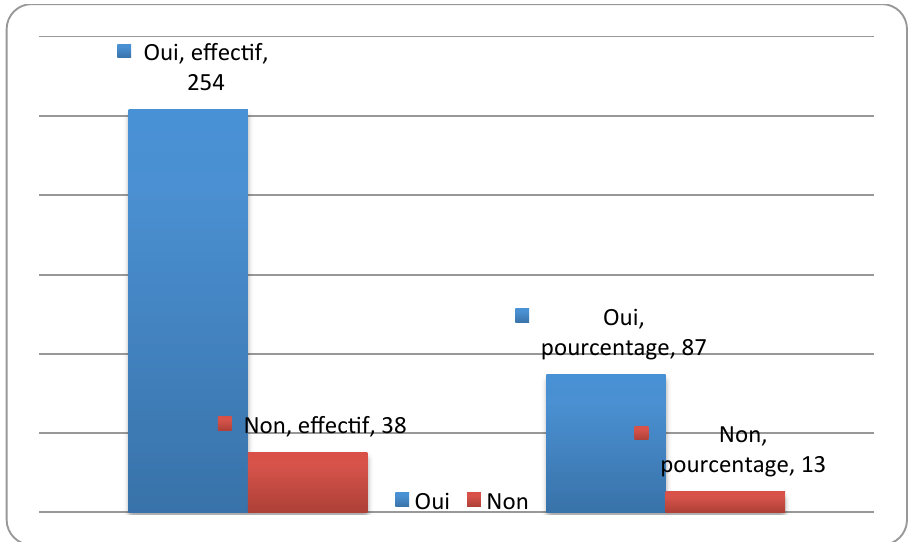
Figure 9. Service d’entretien dans la cité